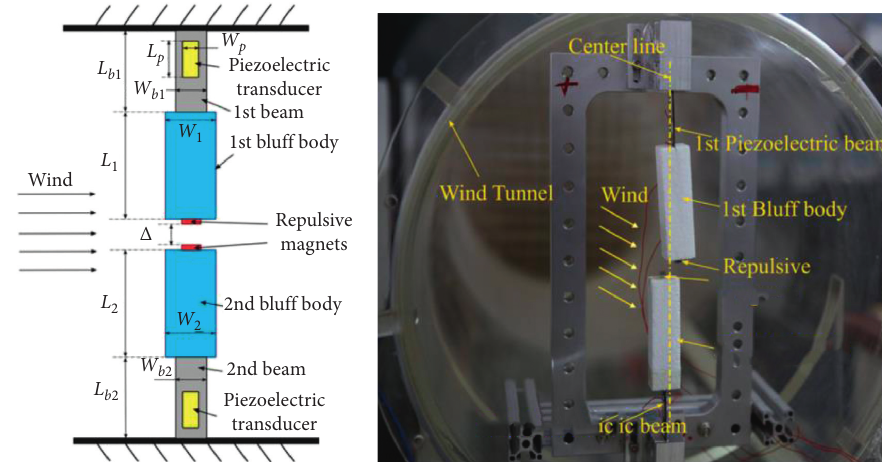
Figure 19: The double-beam piezo-magneto-elastic energy harvester [47].